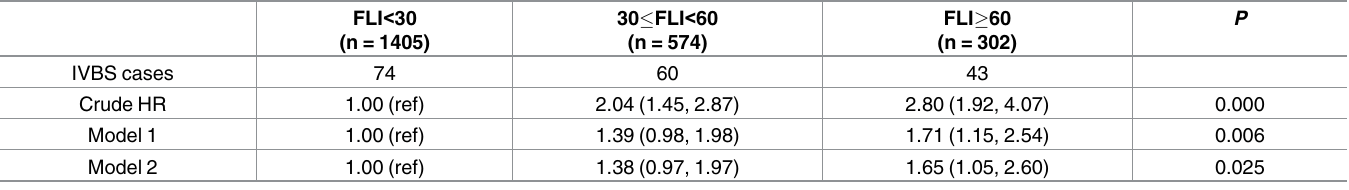
Table 5. Associations of FLI with IVBS in cross-sectional analysis.